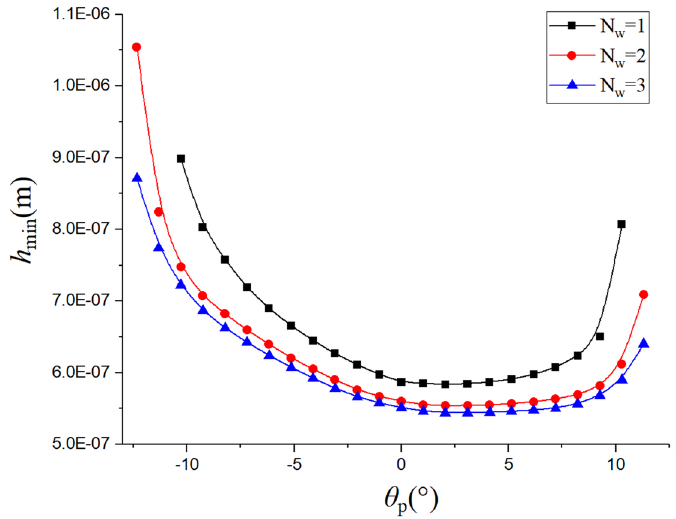
Figure 8. Oil film thickness under different working